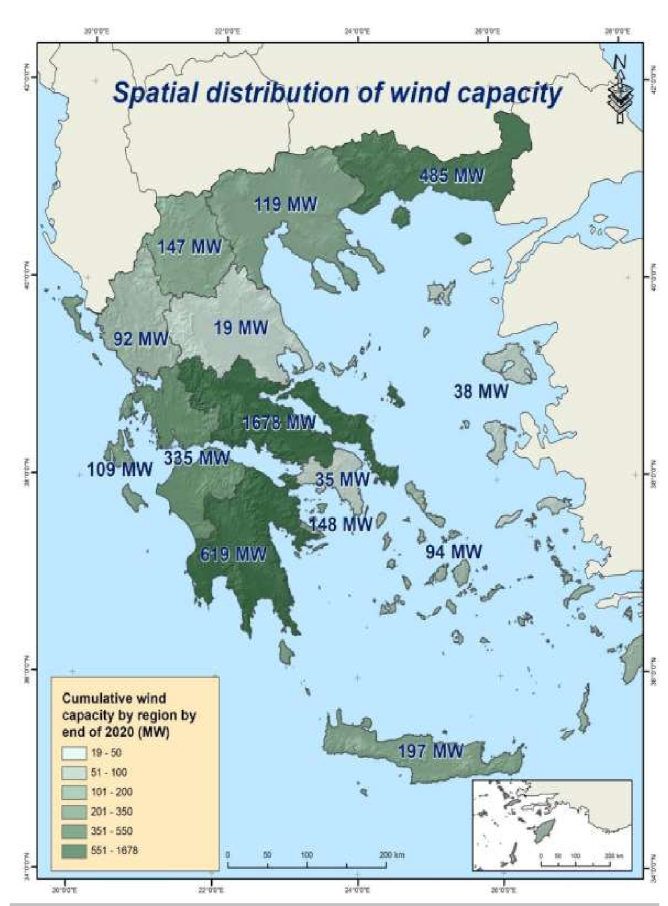
Figure 8. Spatial distribution of wind capacity in Greece (2020)